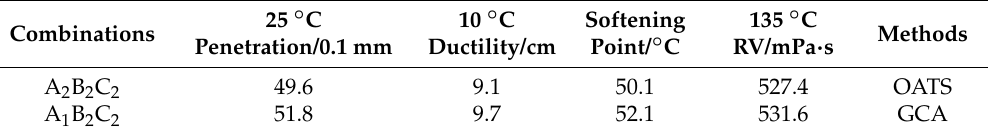
Table 7. Physical properties of Asphalt Binders with Different